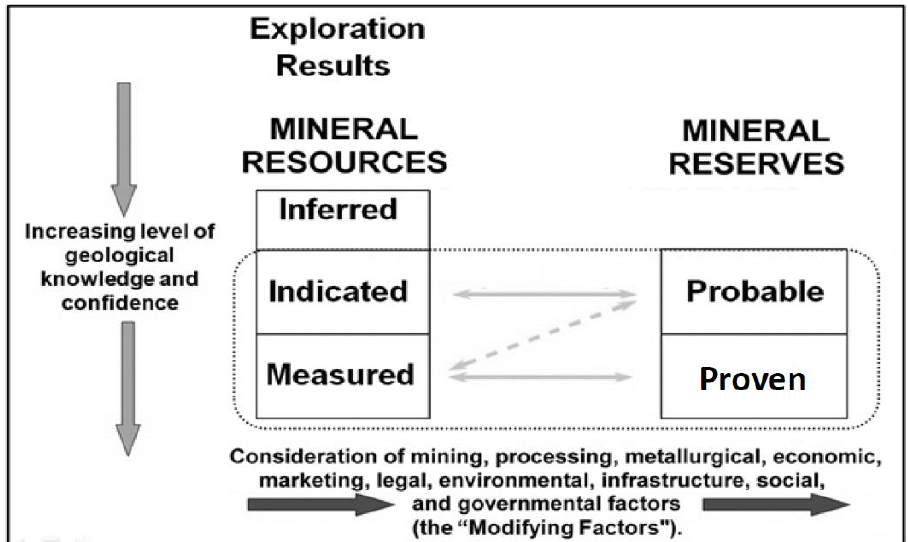
Figure 4. Levels of confidence and relationships for NI43-101 mineral resources and mineral reserves. Source: Canadian Institute of Mining Metallurgy and Petroleum [19].